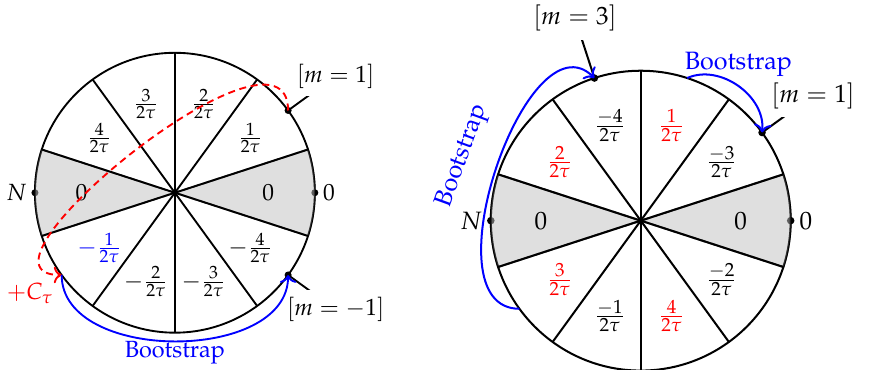
Figure 4. Illustration of MultbyBin when ( m int , m bin ) = ( 1,0 ) . The left figure illustrates the procedure in line 1, and the right figure illustrates the procedure in line